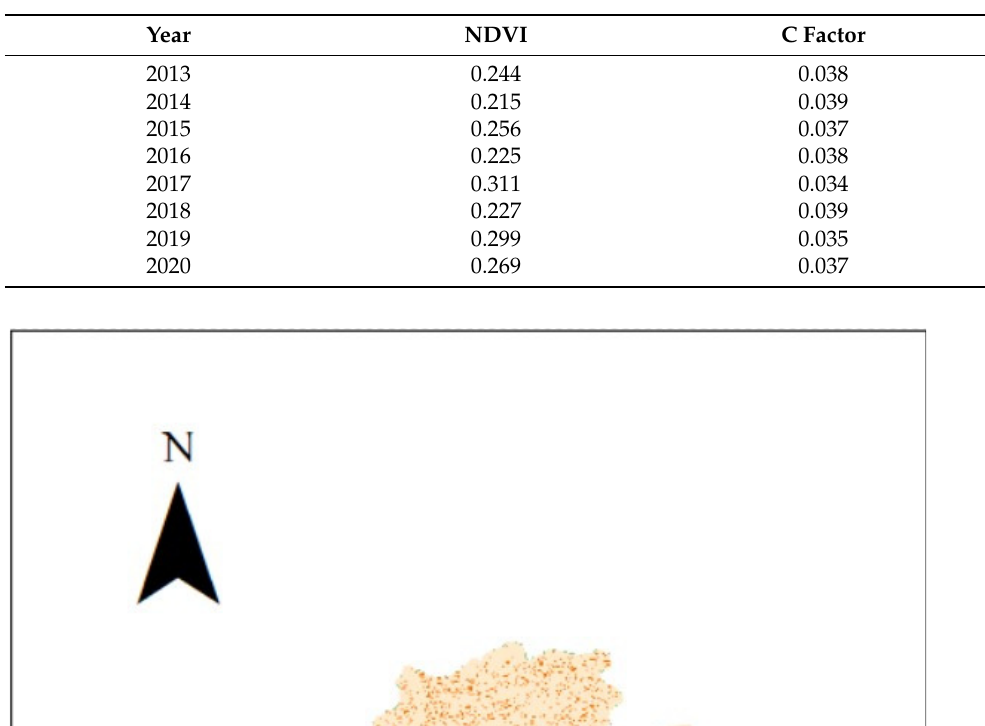
Table 5. Estimated annual mean C factor values from 2013–2020.